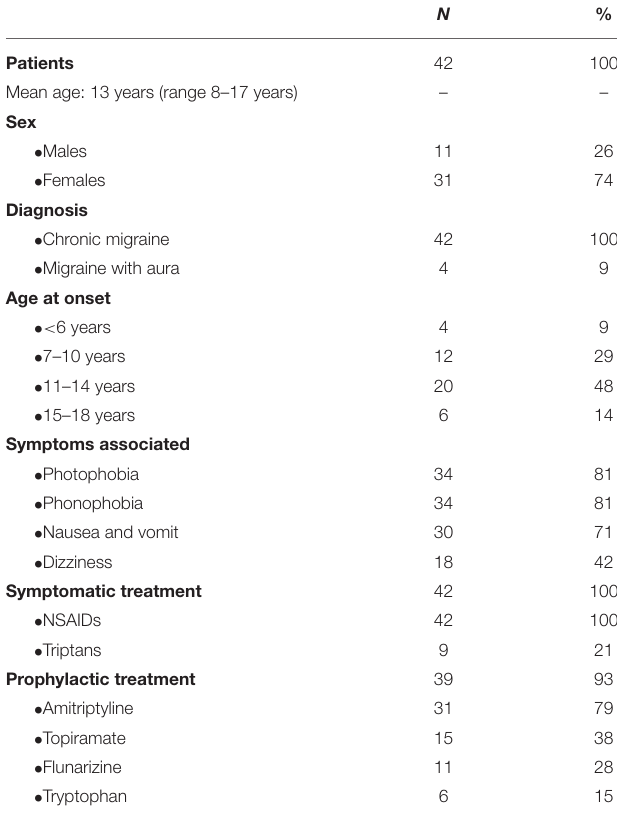
TABLE 2 | Demographic features of patients with chronic migraine and medication